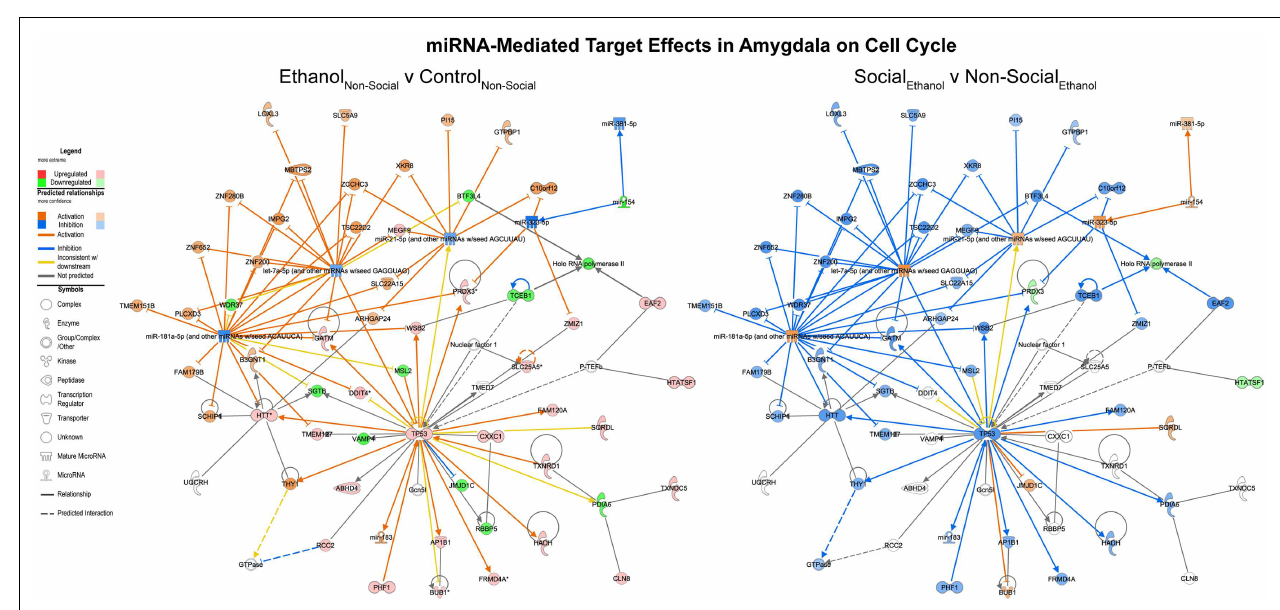
FIGURE 4 | MicroRNA target effects in the amygdala on cell cycle signaling . Conventions same as Figure 3 . Note that nearly all of the genes show a distinct reversal in their expression difference following social enrichment.